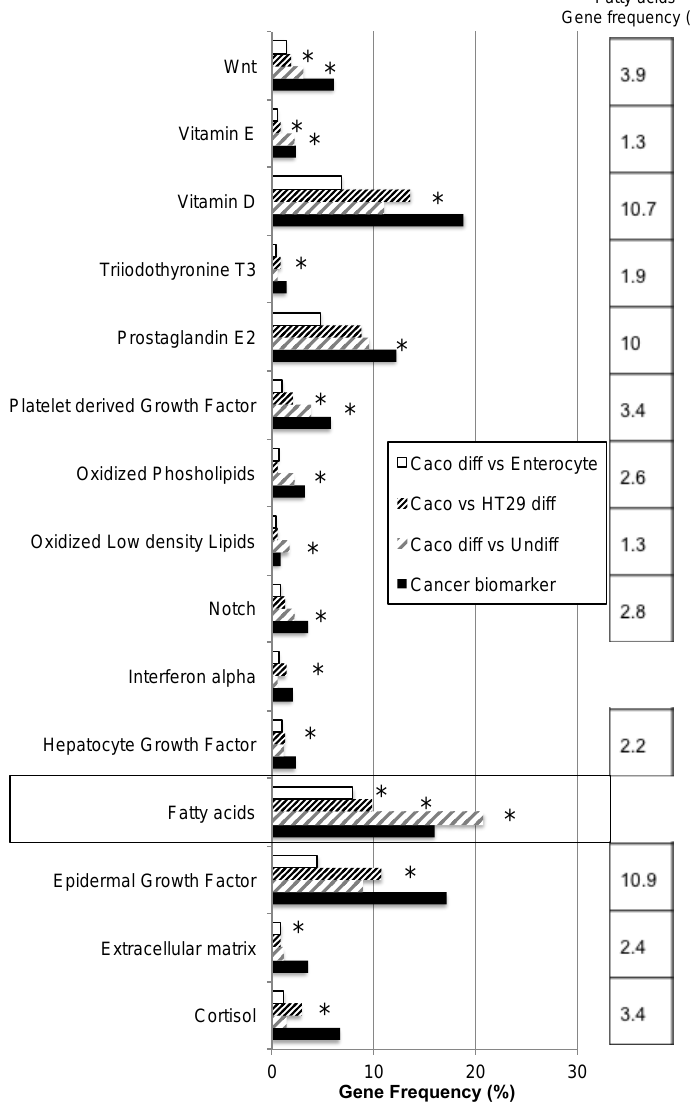
Figure 1. External stimulus gene datasets linked to cancer and intestinal phenotypes. Among the gene datasets regulatable by 49 different stimulus pathways analyzed, 15 are significantly over-represented in cancer phenotype and present significant enrichment in transcriptional targets with healthy intestinal and/or Caco-2 and HT29-MTX differentiated cell lines. Among them, fatty acids have significant number of common regulatable genes with all the pathways dysregulated, except Interferon alpha, their representativity in these pathways is reported in the right column. Z-score confidence level >90% versus genome are indicated by